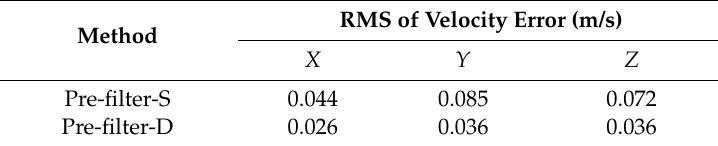
Figure 8. Frequency difference between local and input carriers in field tests.